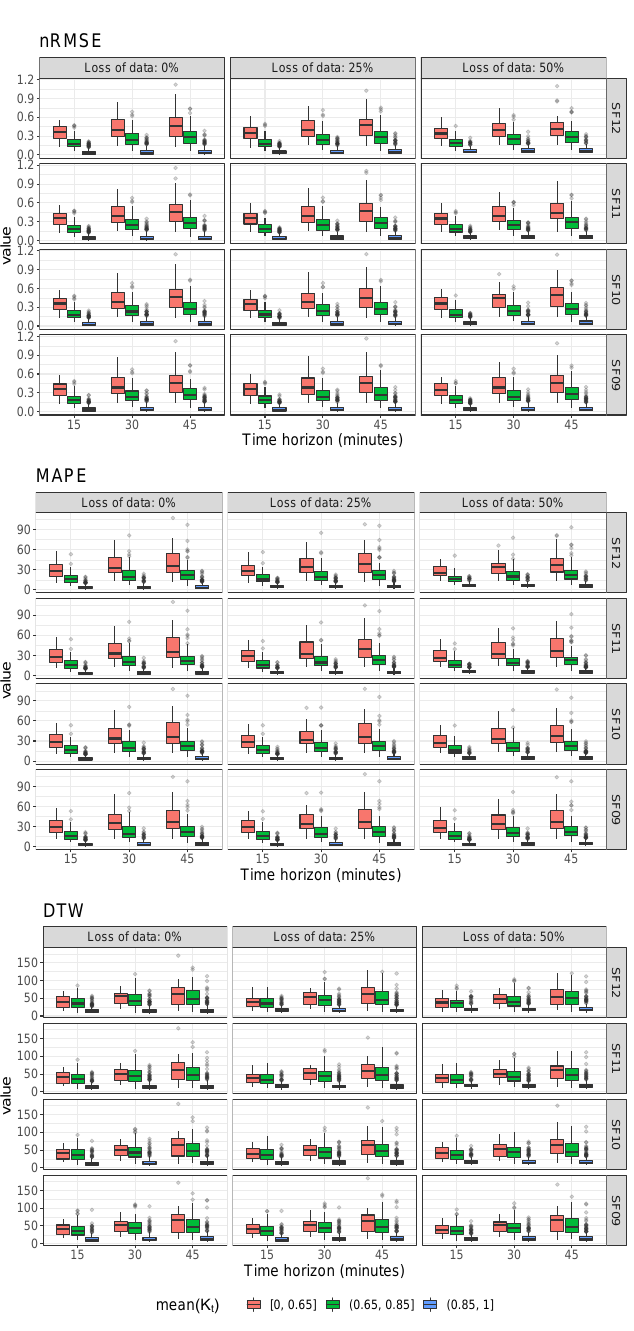
Figure 15. Boxplot of the discrepancies based on nRMSE, MAPE, and DTW. Finally, an additional metric analysis is also provided to compare the difference evolution of SF09, 0% loss of data (corresponding to “Scenario 1” in Figure 4), and for each short time interval to the rest of the other daily possible conditions and under nRMSE, MAPE, and DTW metric estimations. With this aim, Figure 16 summarizes the boxplot results of differences among “Scenario 1” (for each short time interval) and the other daily conditions (SF values, loss of data, and short-term time intervals). As can be seen, differences are higher with larger loss of data for any metric—see boxplots for the same row and short time interval. In addition, discrepancies are increasing from SF09 to SF12, when loss of data and short time interval variables are kept constant. The results under different daily conditions are divided by considering clear sky GHI ratio intervals K t —[0, 0.65], (0.65, 0.85], and (0.85, 1]. The corresponding boxplot differences for SF09, 0%